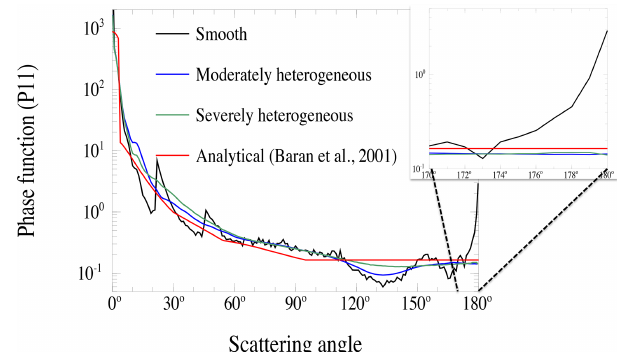
Figure 5. Examples of phase functions for different degrees of par- ticle heterogeneity. Black line: phase function for a bulk ice crystal with a smooth surface; blue line: introduction of some heterogene- ity; green line: maximum degree of heterogeneity (particle rough- ness, air bubbles). The red line represents the phase function ob- tained from the parametrization of Baran et al. (2001).